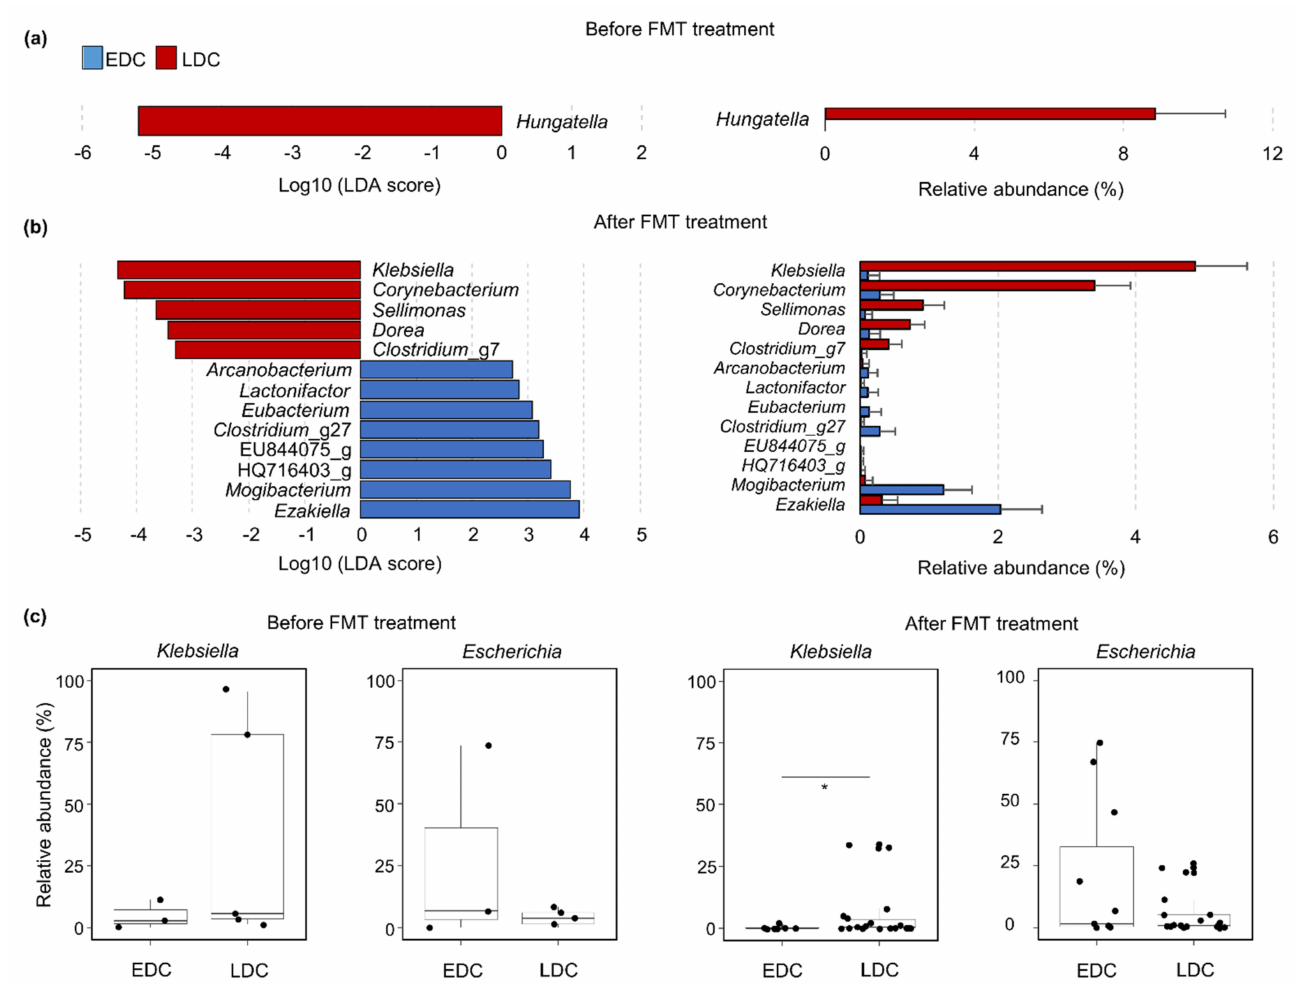
Figure 3. Significantly different genera between the EDC and LDC groups ( a ) before FMT and ( b ) within 4 weeks after FMT were determined by LEfSe analysis. The relative abundances of different genera were compared between the EDC and LDC groups. Genera with a logarithmic LDA score >2.0 were selected as significantly different genera. ( c ) Relative abundances of Klebsiella and Escherichia were compared between the EDC and LDC groups before and after FMT treatments. * p < 0.05. EDC, early decolonization; LDC, late decolonization; FMT, fecal microbiota transplantation; LEfSe, linear discriminant analysis effect size; LDA, linear discriminant